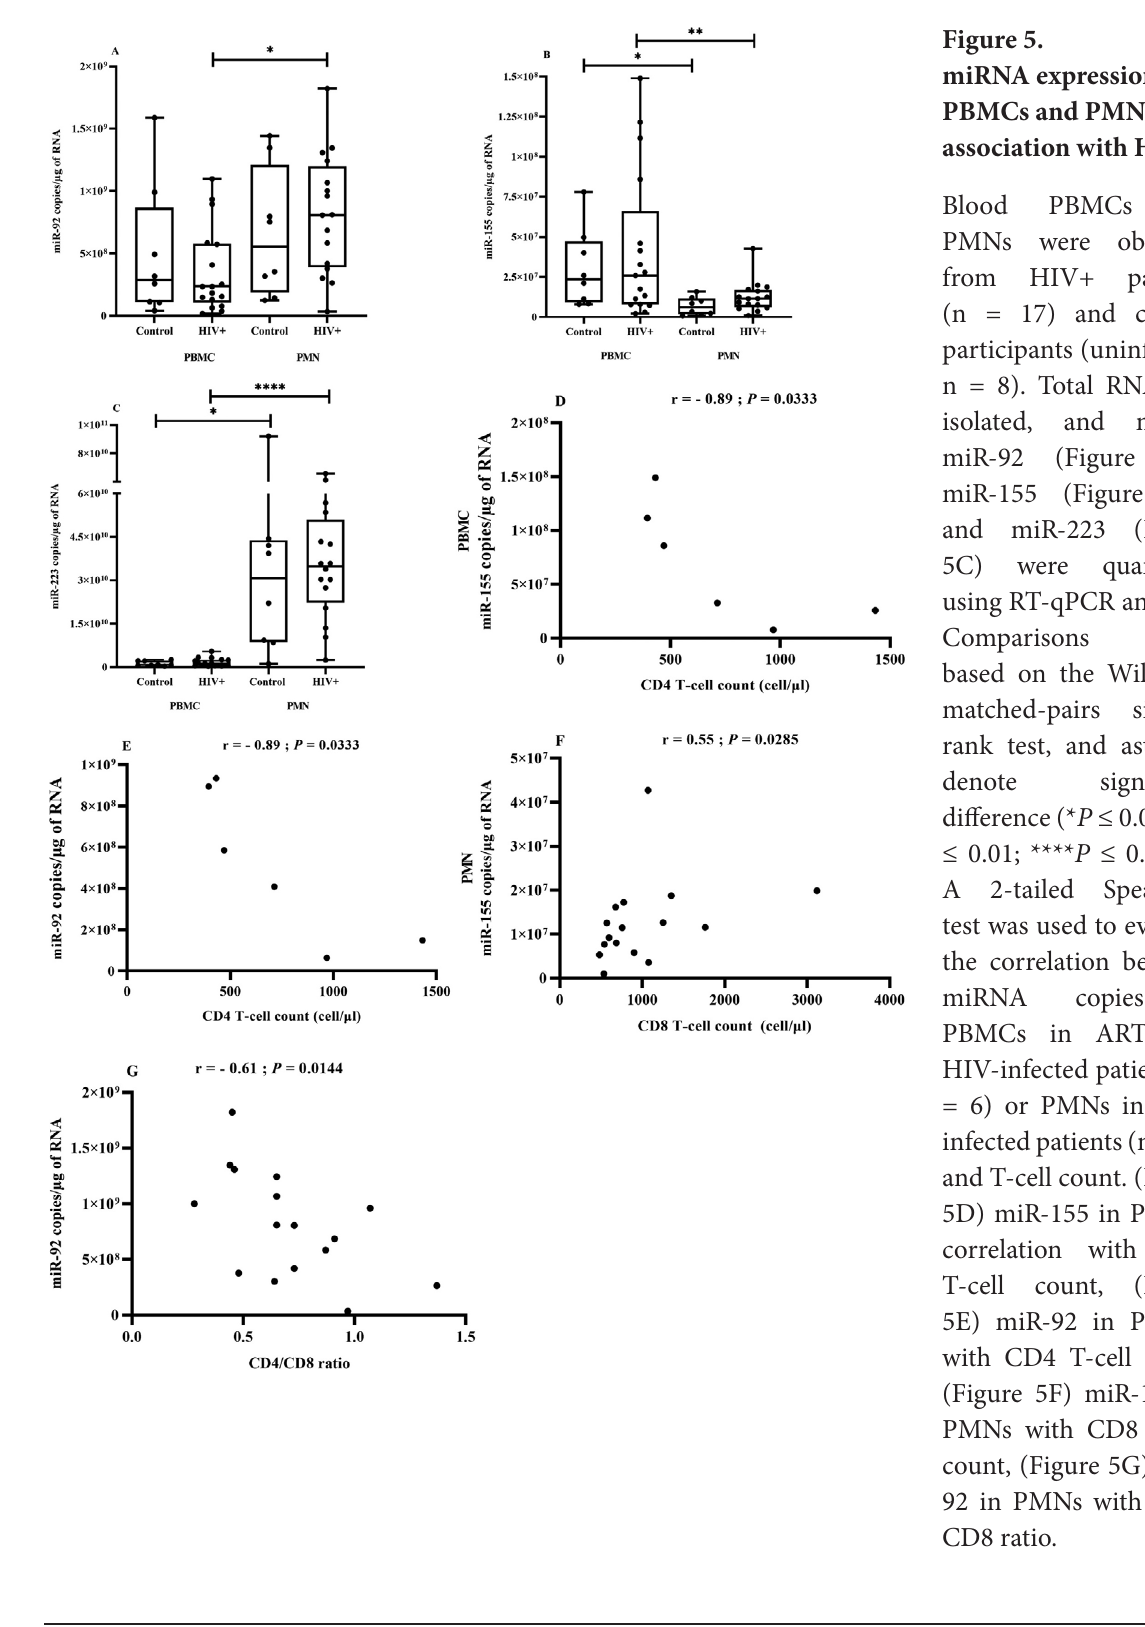
Figure 5. miRNA expression in PBMCs and PMNs in association with HIV. Blood PBMCs and PMNs were obtained from HIV+ patients (n = 17) and control participants (uninfected, n = 8). Total RNA was isolated, and mature miR-92 (Figure 5A), miR-155 (Figure 5B), and miR-223 (Figure 5C) were quantified using RT-qPCR analysis. Comparisons are based on the Wilcoxon matched-pairs signed- rank test, and asterisks denote significant difference (* P ≤ 0.05; ** P A 2-tailed Spearman test was used to evaluate the correlation between miRNA copies in PBMCs in ART-naive